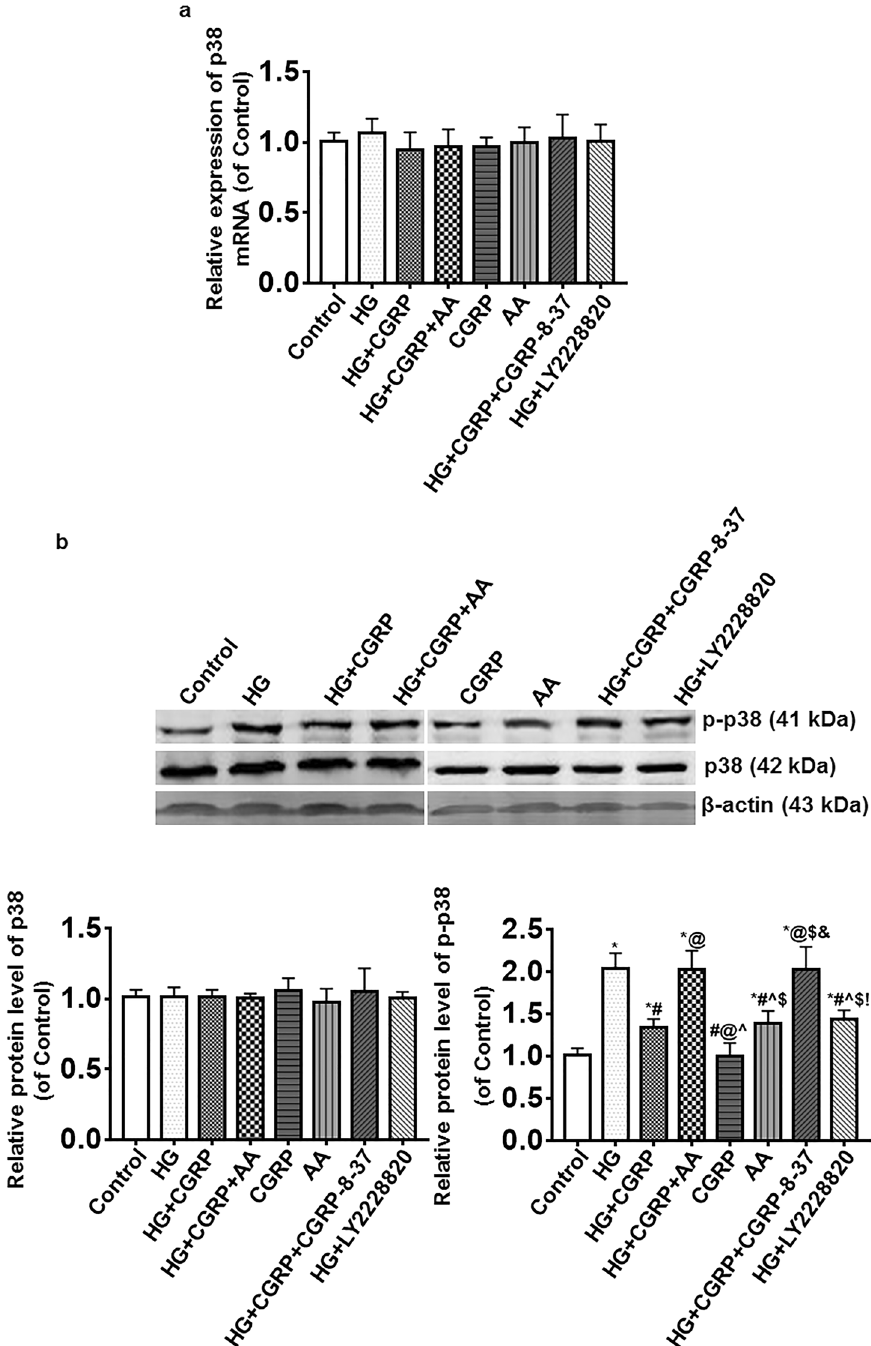
Figure 4. The expressions of p38 MAPK in BSMCs were detected by qRT-PCR and Western blot. ( a ) The expression of p38 mRNA in the groups was no significant change. ( b ) The expression of p38 protein in the groups was no significant change. Compared with the control and CGRP groups, the expression of p-p38 protein in AA group increased. The expression of p-p38 protein in the HG group was notably increased, the degree of the change was reduced when BSMCs were treated with CGRP or LY2228820 at the same time, and AA or CGRP-8-37 could suppress the effect of CGRP on the expression of p-p38 protein in BSMCs under HG. . * VS. control group, p < 0.05; # VS. HG group, p < 0.05; @ VS. HG + CGRP group, p < 0.05; ^ VS. HG + CGRP + AA group, p < 0.05; $ VS. CGRP group, p < 0.05; & VS. AA group, p < 0.05; ! VS. HG + CGRP + CGRP-8-37 group, p < 0.05. n = 6. The bar charts were created by GraghPad Prism 7.0 software (Version 7.00, URL: www. graph pad. com). The Western blot bands were created by Odyssey 3.0 image analysis system software (Version 1.2.15, URL: www. licor. com/ bio/ suppo rtsup